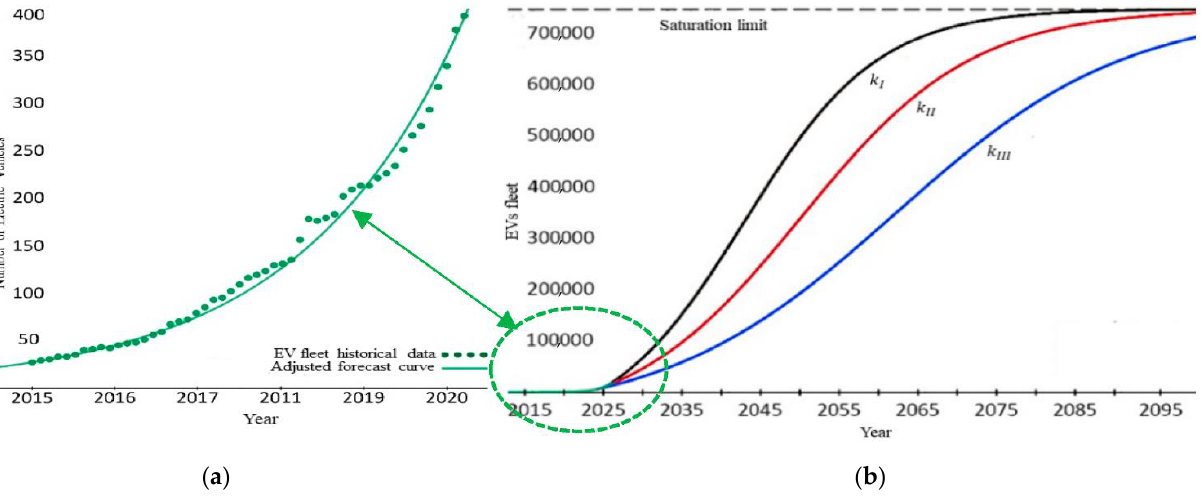
Figure 6. Logistics growth projections for the EV fleet in Campinas. ( a ) Comparison of model output with historical electric vehicle fleet records. ( b ) Scenarios 1, 2, and 3 for the logistical growth curve of the EV fleet in Campinas, for long-term projections.